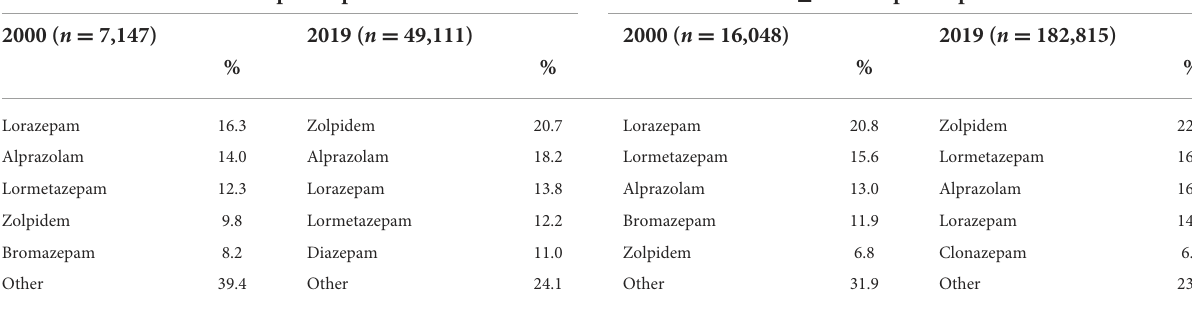
TABLE 2 Distribution of BZRA prescribed in 2000 and 2019 ( n : number of